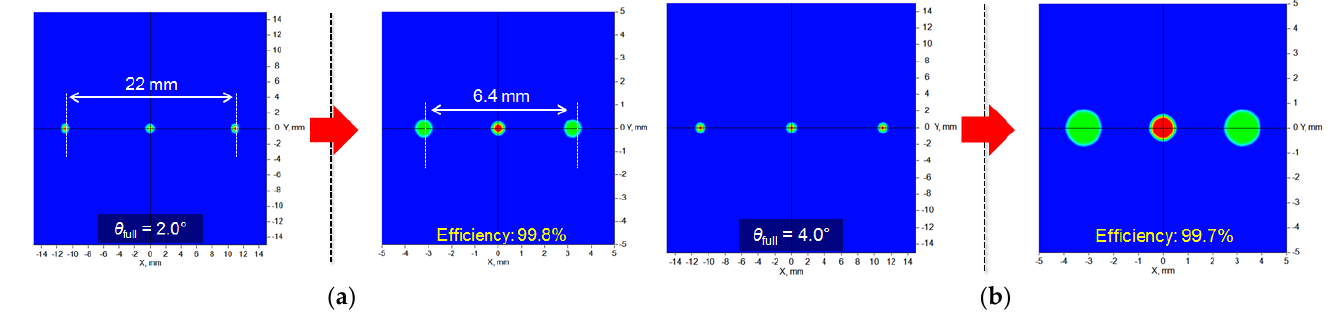
Figure 5. Beam spacing and size characteristics according to the divergence angle of a rhombus prism: ( a ) θ full = 2 ◦ ; ( b ) θ full = 4 ◦ .